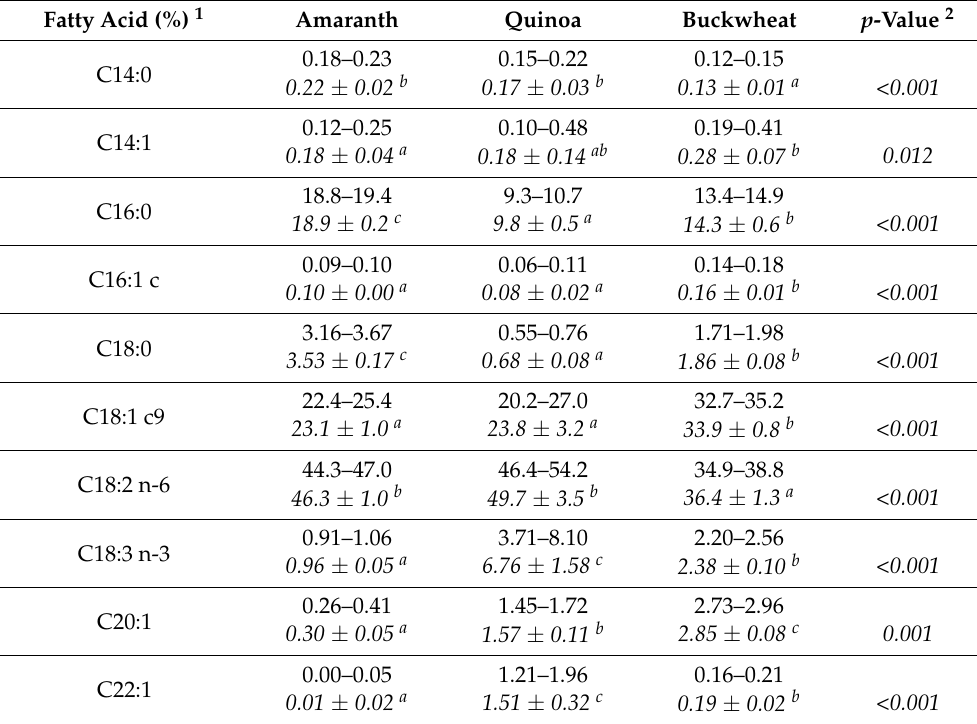
Table 4. Fatty acid composition (% of total fatty acid methyl esters) of amaranth ( n = 8), quinoa ( n = 7) and buckwheat ( n = 10) wholemeal